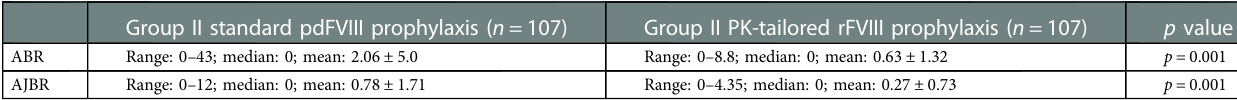
TABLE 4 Comparison of bleeding outcomes in patients on PK-tailored prophylaxis regimen, before and after FVIII product switch. Group II standard pdFVIII prophylaxis ( n = 107)